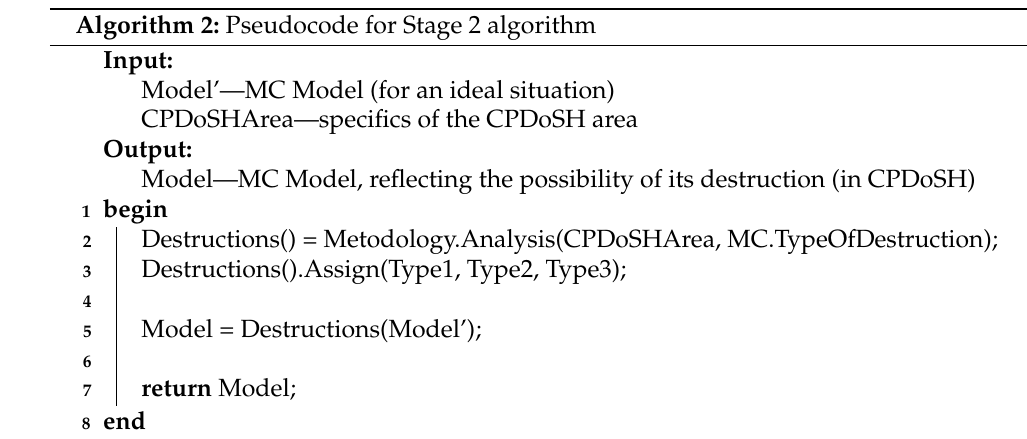
Algorithm 2 receives a Model for an ideal situation ( Model (cid:48) ) and CPDoSHArea